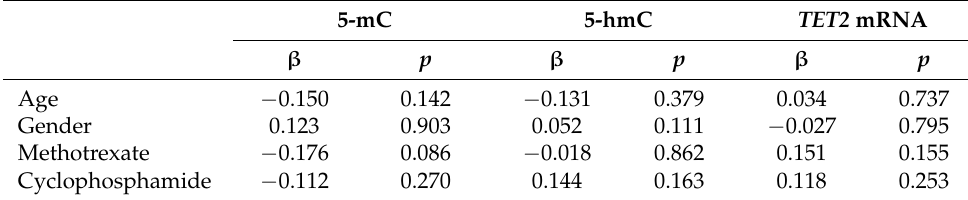
Table 3. Multivariate linear regression of factors related to alteration of methylation pattern.